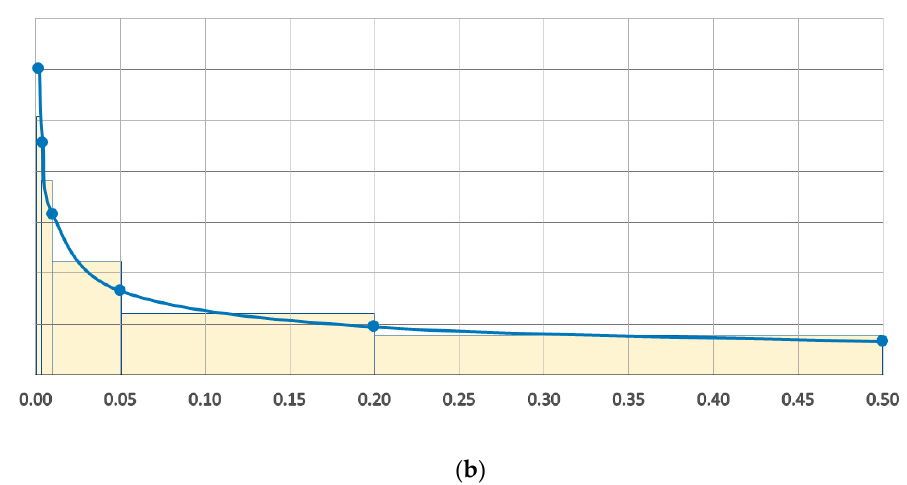
Figure 3. The upper panel (a) presents depth–damage functions based on different flood schemes of the most frequent SpCode groups (please see Study Sample) while the lower panel (b) is an example of the associated and underlying loss–probability curve in which damage % on the y-axis is related the properties unique risk profile (x-axis).